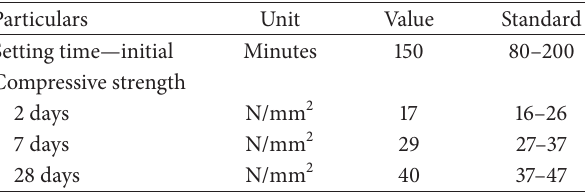
Table 1: Properties of the cement used.